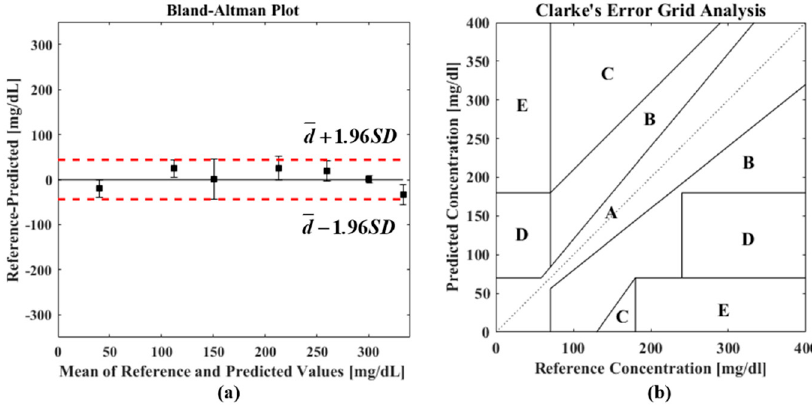
Figure 2. Examples of ( a ) a Bland–Altman plot and ( b ) a Clarke Error Grid (CEG) Analysis.